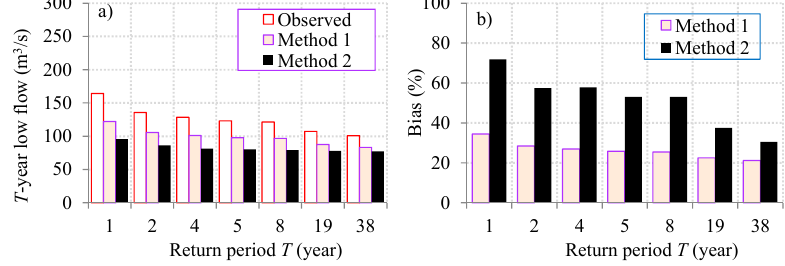
Figure 8. Return period T against: ( a ) T -year low flow ( H ) after back-transformation from (1/ H ); and ( b ) bias on the T -year low flow ( H ).